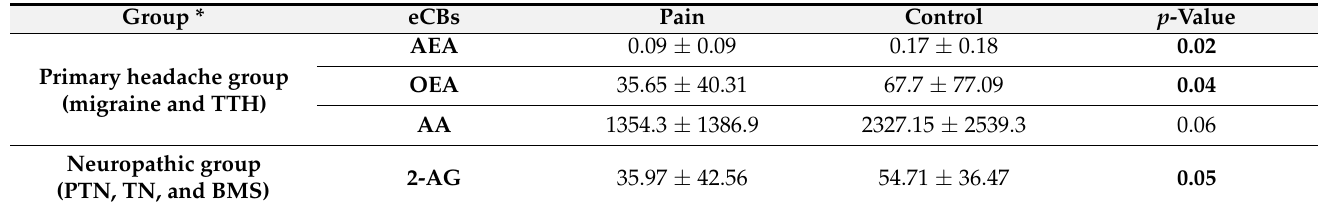
Table 1. Salivary eCB levels in primary headache and neuropathic pain groups compared with the controls (mean ± SD; fmol/mg protein).